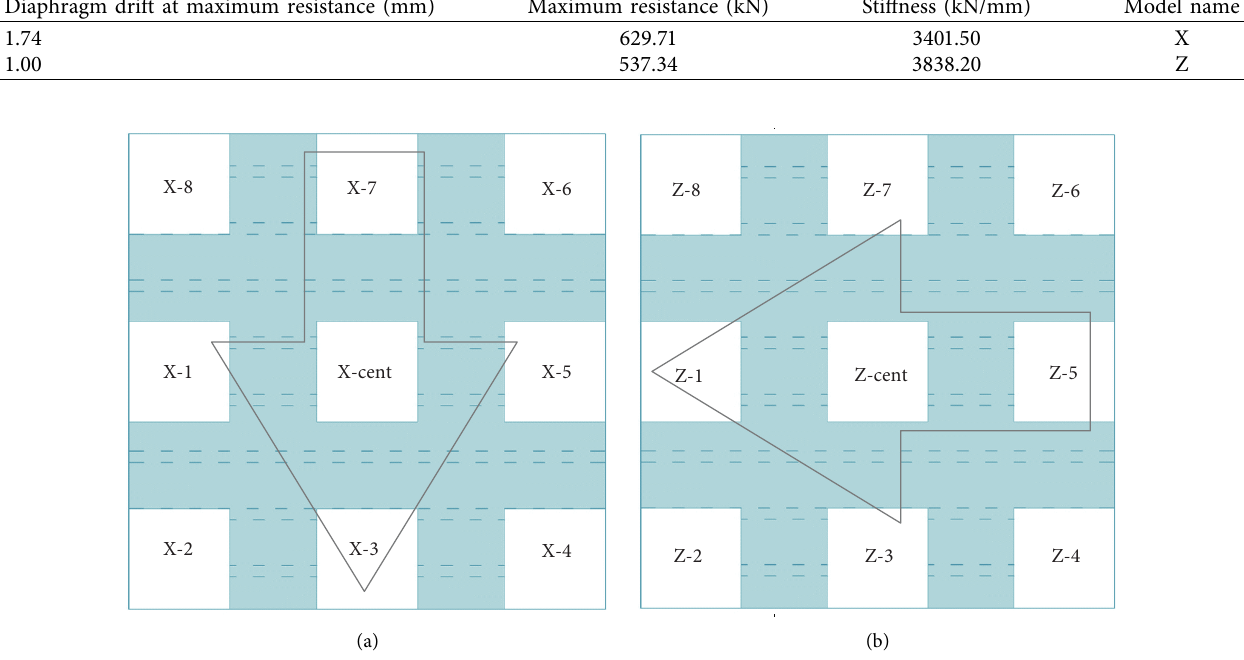
Figure 15: Location of the opening and name of the correspondent model for loading in Z directions. (a) Pop-up location of the cor-